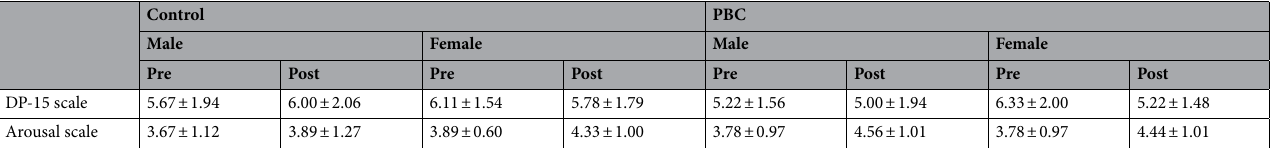
Table 2. Subjective measurements during the inhibition task of the Stroop test. Data are presented as mean ± SD. PBC partial body cryotherapy. *Significant p <